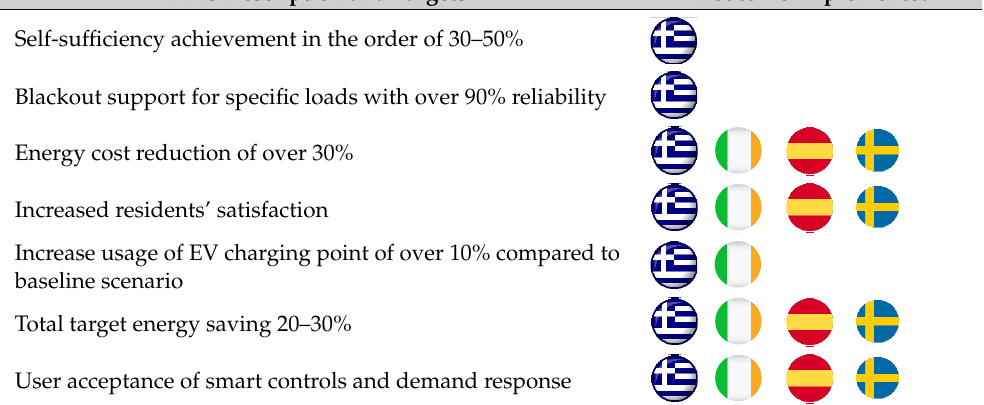
Table 4. Pilots’ KPIs .